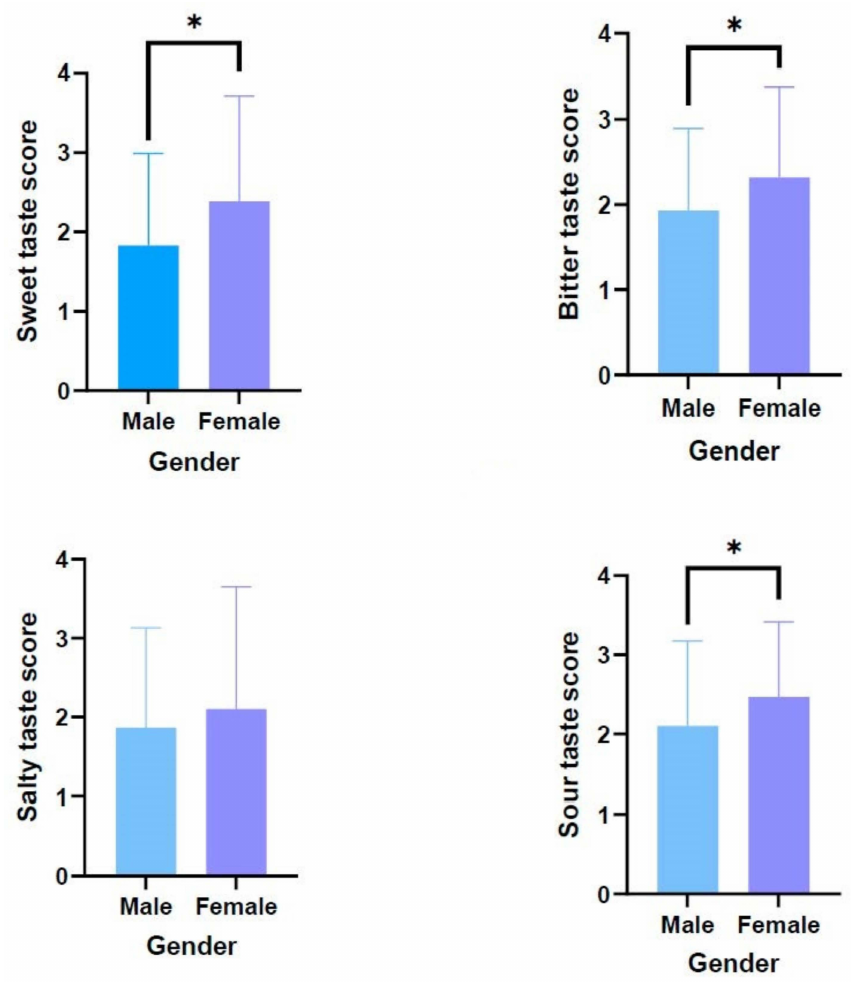
Figure 1. Differences in taste score by gender. The findings are presented as X ± SD. The use of a single asterisk (*) denotes the existence of statistically significant differences between the groups ( p <